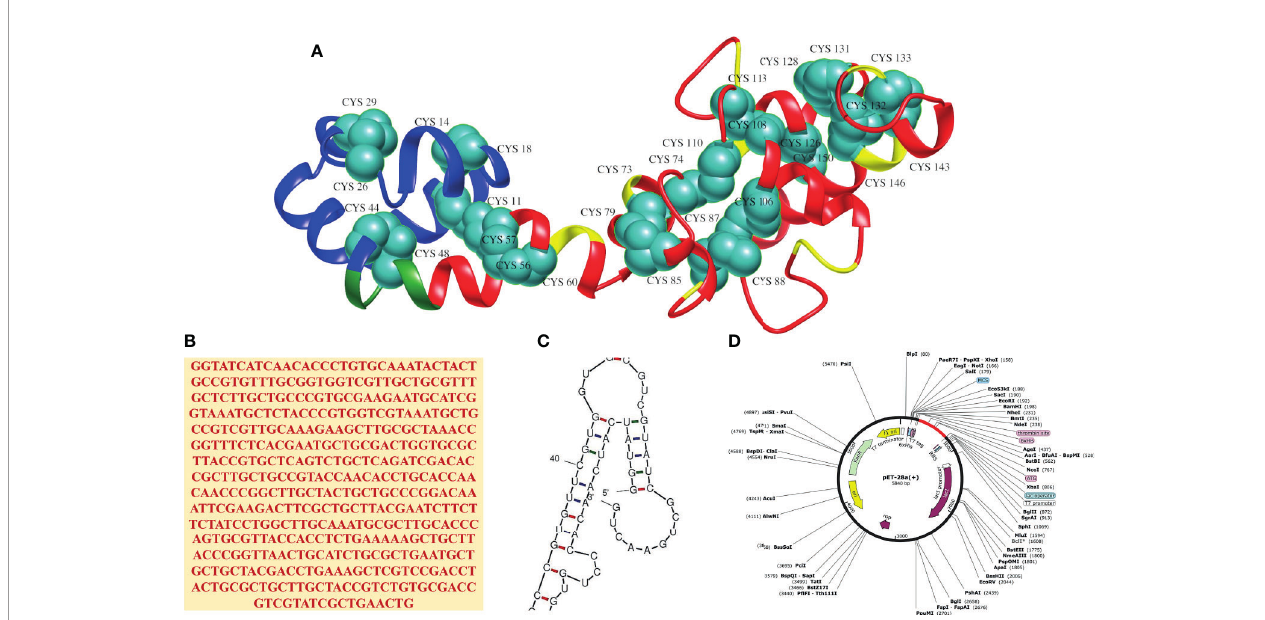
FIGURE 4 | (A) 3D structure of the MEV after disul fi de engineering with mutated residue are shown in cyan-green spheres, (B) Reverse translated primary DNA sequence of the MEV, (C) Closeup view of start-site of MEV RNA structure (full structure is given in Figure S1 ) and (D) In silico cloning of MEV (shown in red) in pET28a(+) vector.